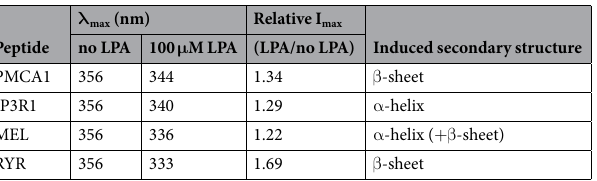
Table 2. Peptide tryptophan fluorescence in the presence and absence of LPA. Data refer to the spectra shown in Fig. 2. Secondary structures are according to the CD spectroscopy-based